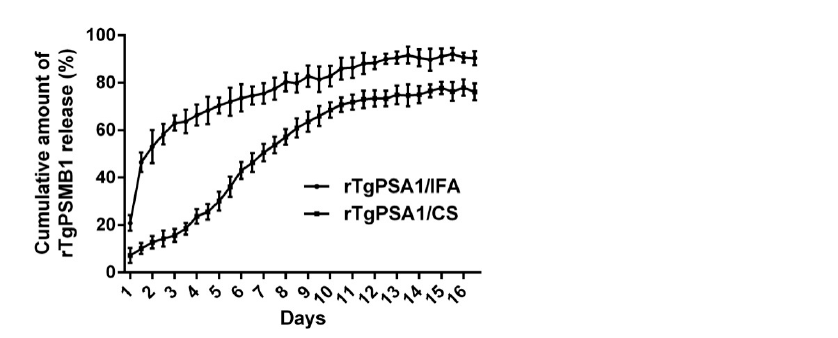
Figure 2. SEM images of CS nanospheres loaded with rTgPSA1 protein, showing nanosphere morphology, with bar representing ( a ) 1000 nm and ( b ) 500 nm.